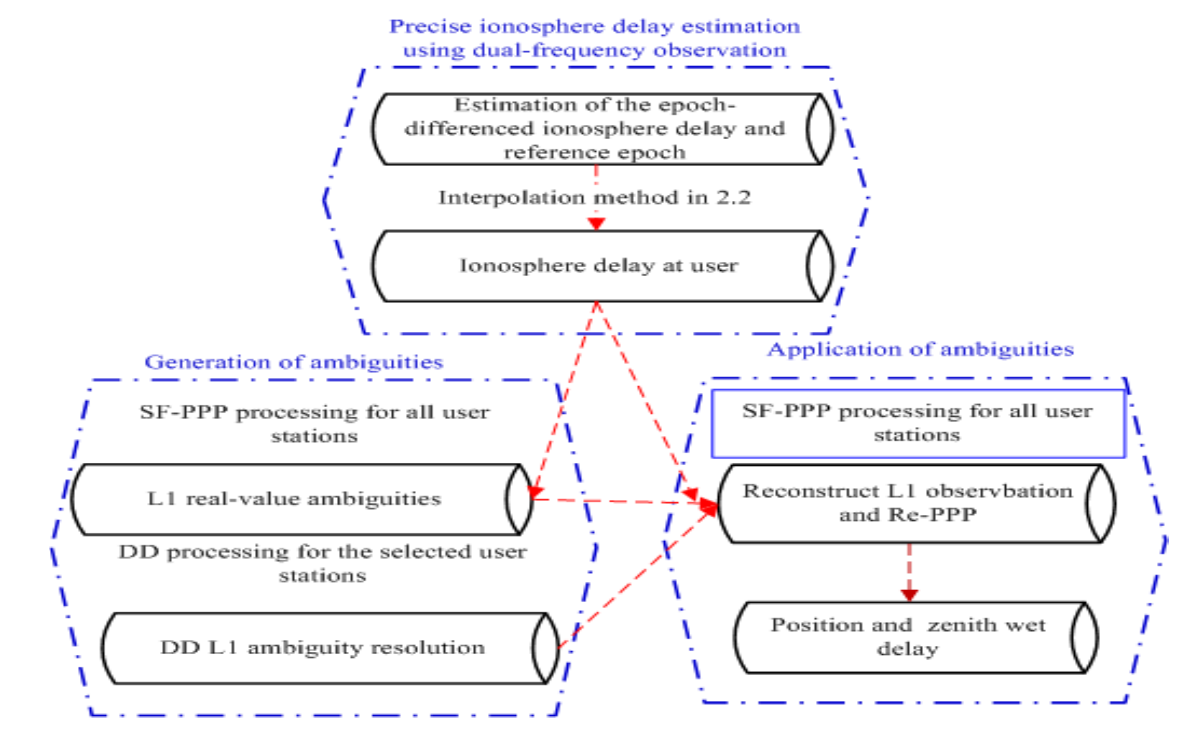
Figure 1. Flowchart of the estimation and interpolation of the precise ionosphere delay and the introduction of the DD ambiguity into SF-PPP.